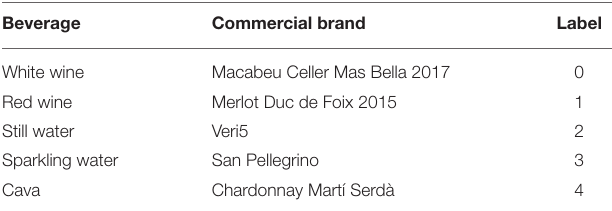
TABLE 2 | Beverages represented in the MicroBeTa dataset, along with the label values they were assigned. Beverage Commercial brand